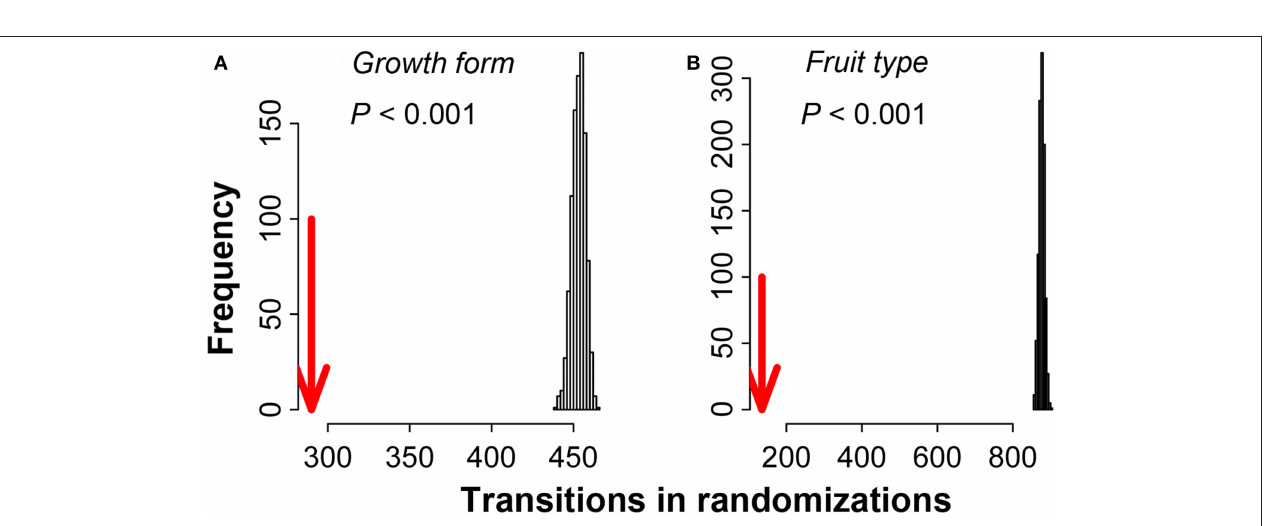
Frontiers in Ecology and Evolution |